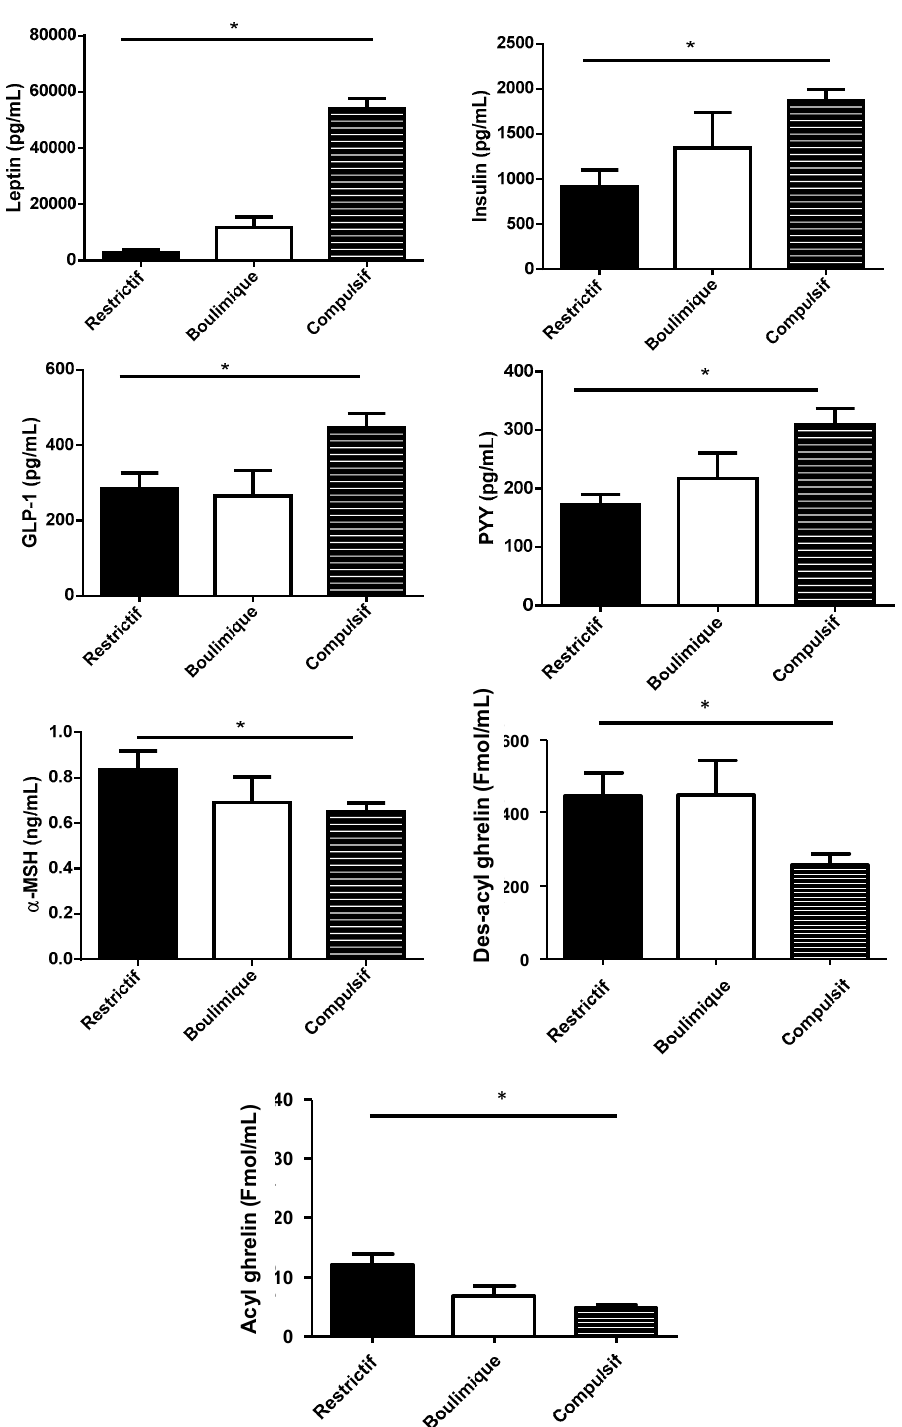
Figure 1. Plasma concentration of peptides associated with food intake according to broad categories of ED. * Significance after adjustment on age and sex. The standard deviation is represented by the error bar.